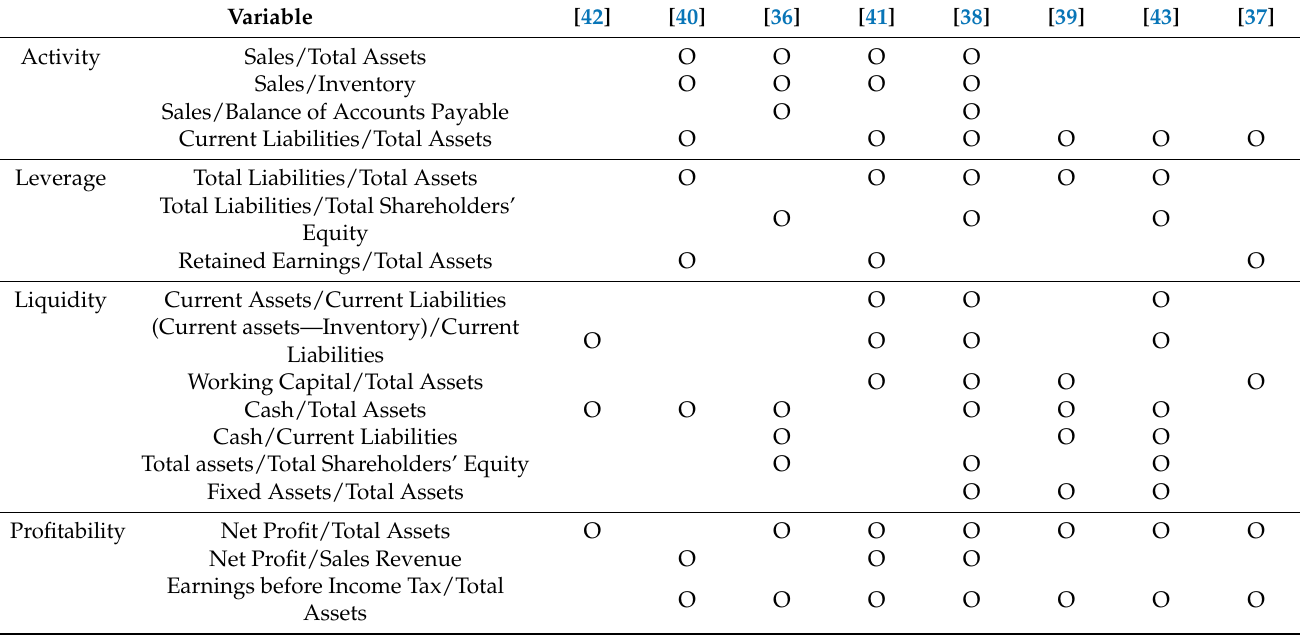
Table 1. Input Variable (Financial